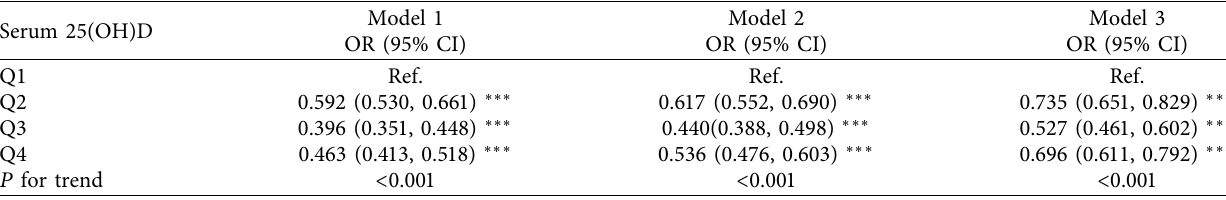
Table 2: Adjusted ORs for associations between serum 25(OH)D and the risk of anemia.